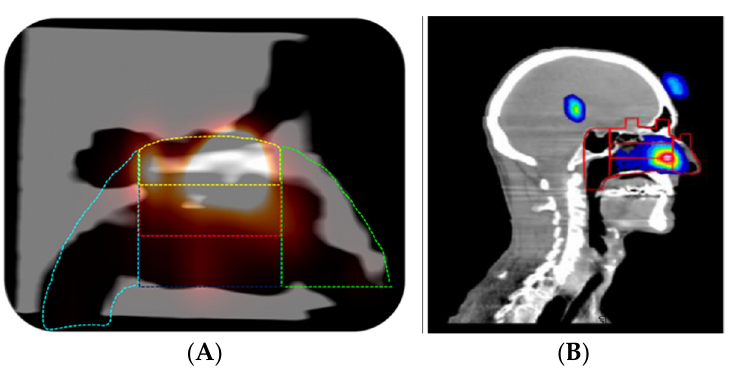
Figure 9. In vitro ( A ) vs. in vivo ( B ) deposition patterns as assessed by scintigraphy. The colour lines in the figure outline the regions of interest (ROI) in both the nasal cast ( A ) and human volun- teers ( B